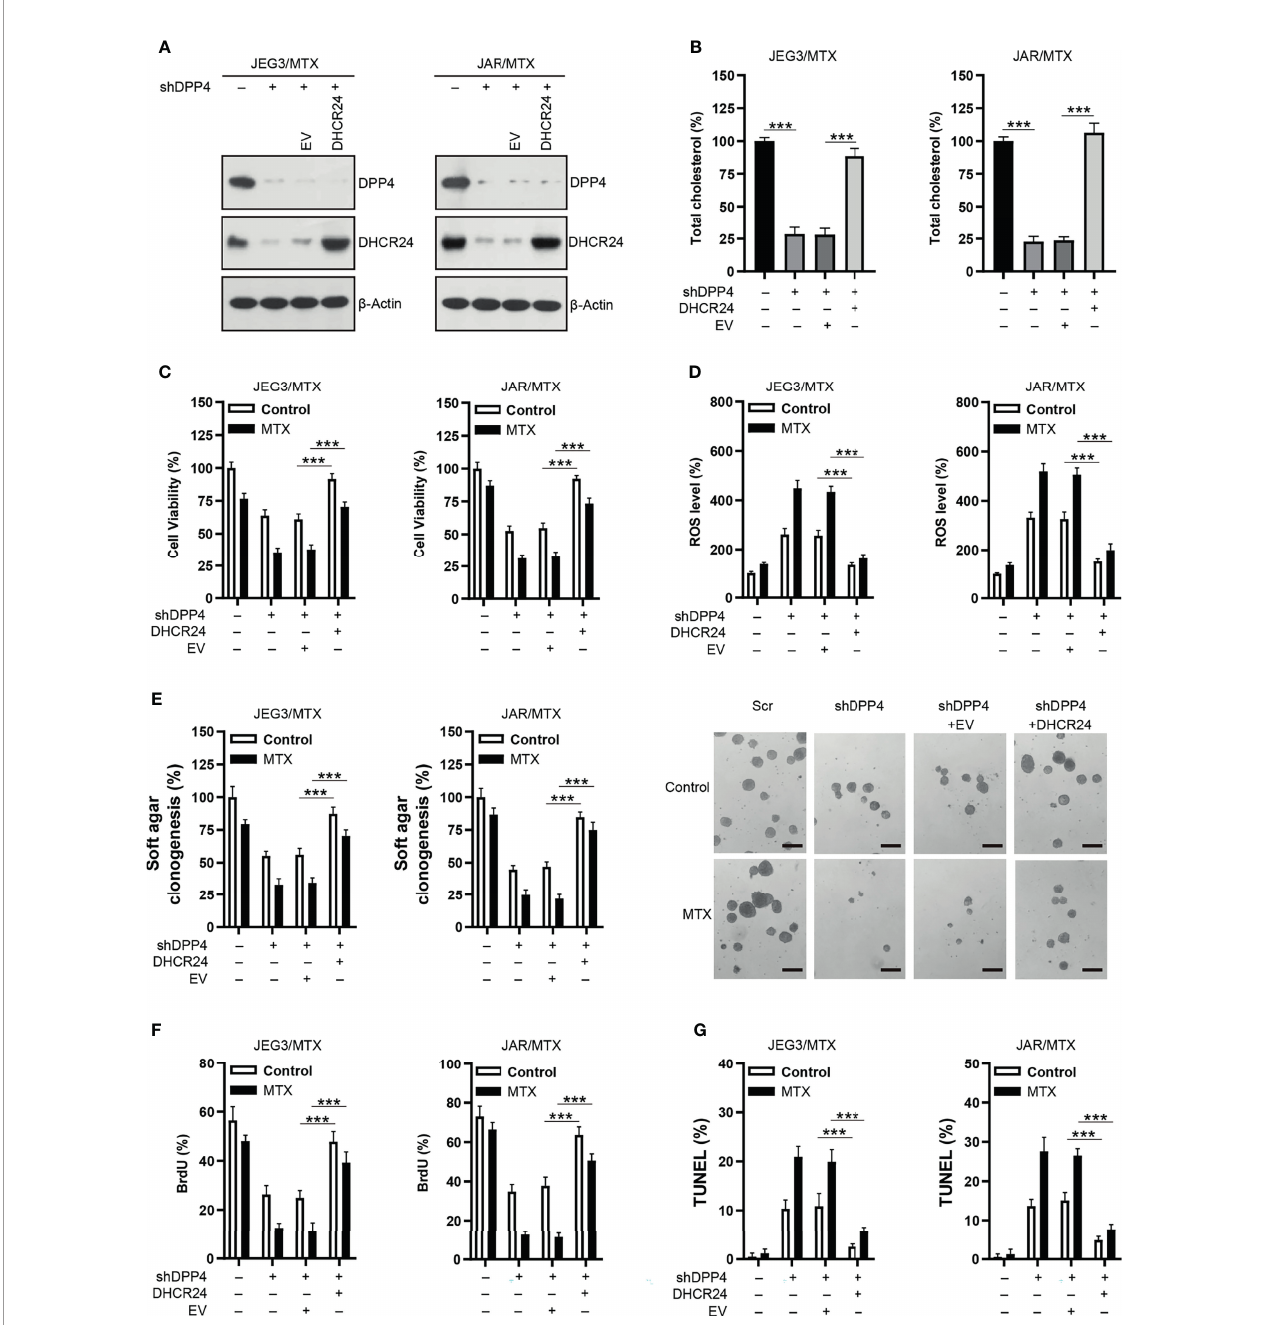
FIGURE 5 | Over-expression of DHCR24 rescues the effect of DPP4 knockdown on MTX-resistant GTN cells. (A) Over-expression of DHCR24 in DPP4-depleted JEG3/MTX and JAR/MTX cells. (B) DHCR24 expression effectively restored cellular cholesterol level in DPP4-depleted JEG3/MTX and JAR/MTX cells. The cellular cholesterol level in Scr was regarded as 100%. n=4, ***P<0.001. (C) DHCR24 expression promoted MTX resistance in DPP4-depleted JEG3/MTX and JAR/MTX cells. n=4, ***P<0.001. (D) DHCR24 expression attenuated ROS accumulation and caspase-3 activity following MTX treatment in DPP4-depleted JEG3/MTX and JAR/MTX cells. The ROS level in Scr without MTX treatment was regarded as 100%. n=4, ***P<0.001. (E) DHCR24 expression promoted soft agar clonogenesis following MTX treatment in DPP4-depleted JEG3/MTX and JAR/MTX cells. The colony formation in Scr without MTX treatment was regarded as 100%. n=4, ***P<0.001. Micrographs showed the result of JAR/MTX cells. Bars: 200 m m. (F) , DHCR24 expression promoted BrdU incorporation following MTX treatment in DPP4-depleted JEG3/MTX and JAR/MTX cells. n=4, ***P<0.001. (G) DHCR24 expression reduced TUNEL labeling following MTX treatment in DPP4-depleted JEG3/MTX and JAR/MTX cells. n=4,